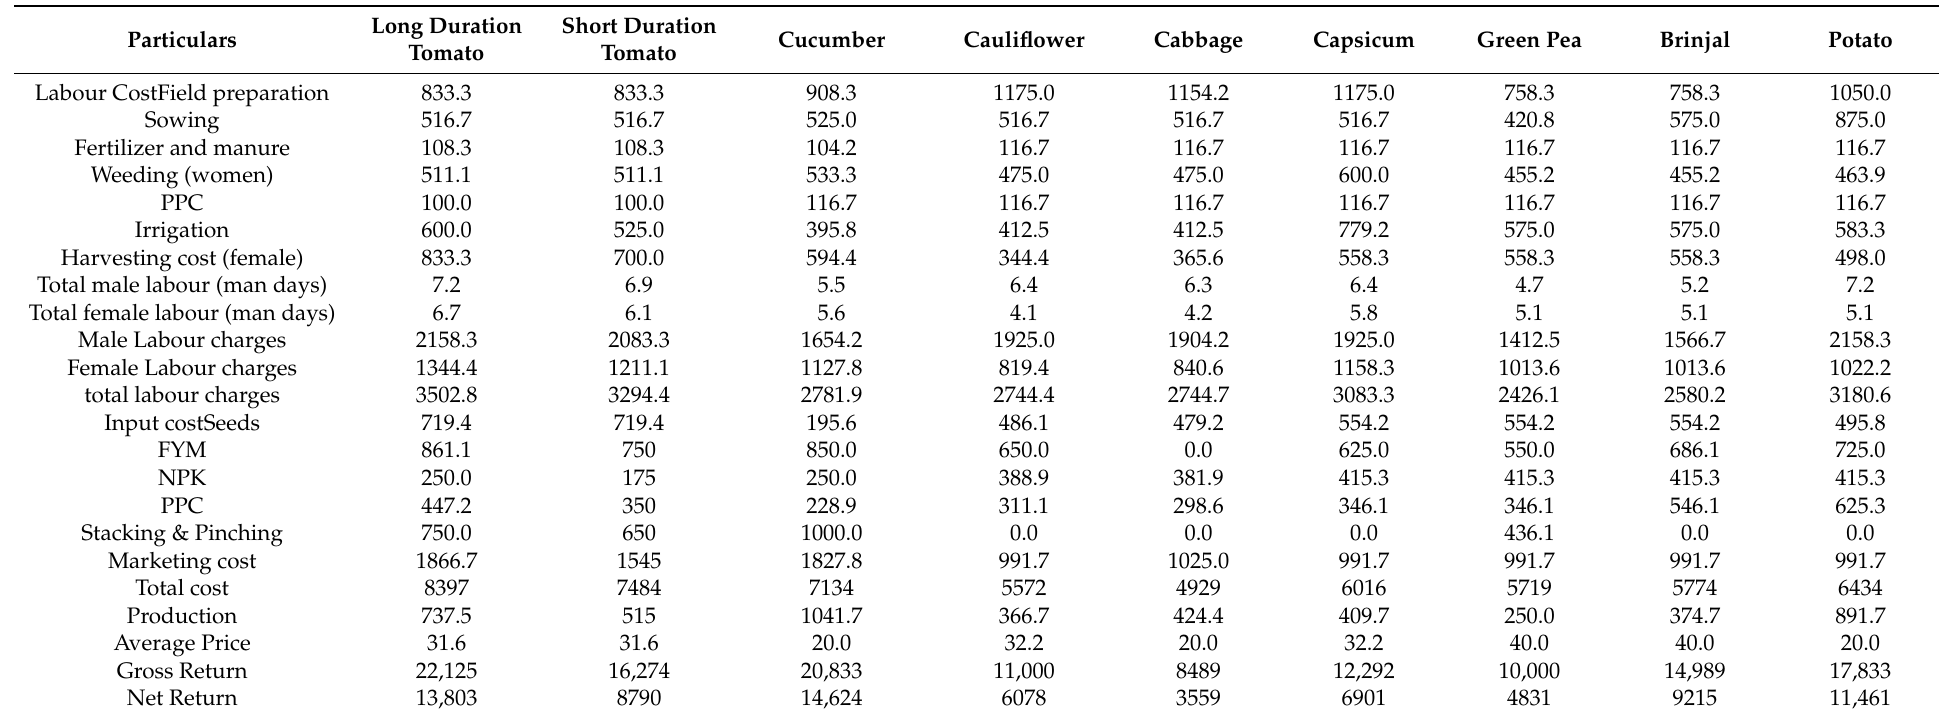
Table 10. Cost of cultivation of major vegetable crops cultivated under polyhouse in Almora district of Uttarakhand (size 100 m 2 ; Amount in